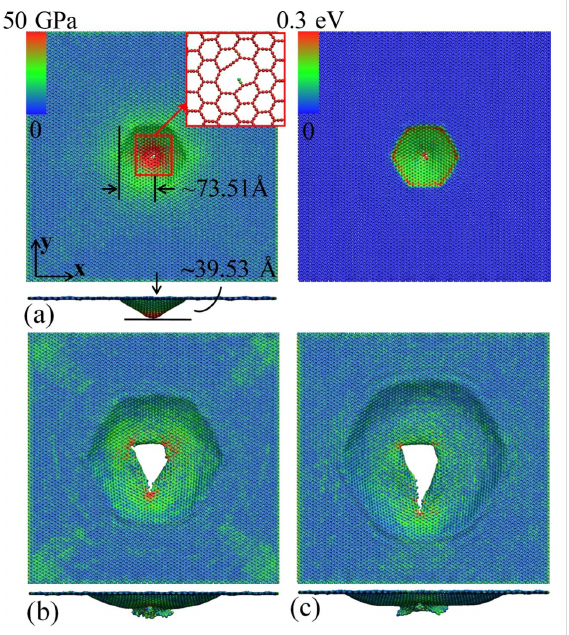
Figure 3: Impact deformation of α -GY under an impact velocity of 2 km/s. (a) von Mises atomic stress distribution pattern at a simulation time of 2.5 ps (left panel), and the corresponding kinetic energy distri- bution pattern (right panel). The insert in the left panel shows the for- mation of initial cracks at the impact area; (b) stress distribution pattern right after perforation at 5.0 ps; and (c) the final atomic configuration